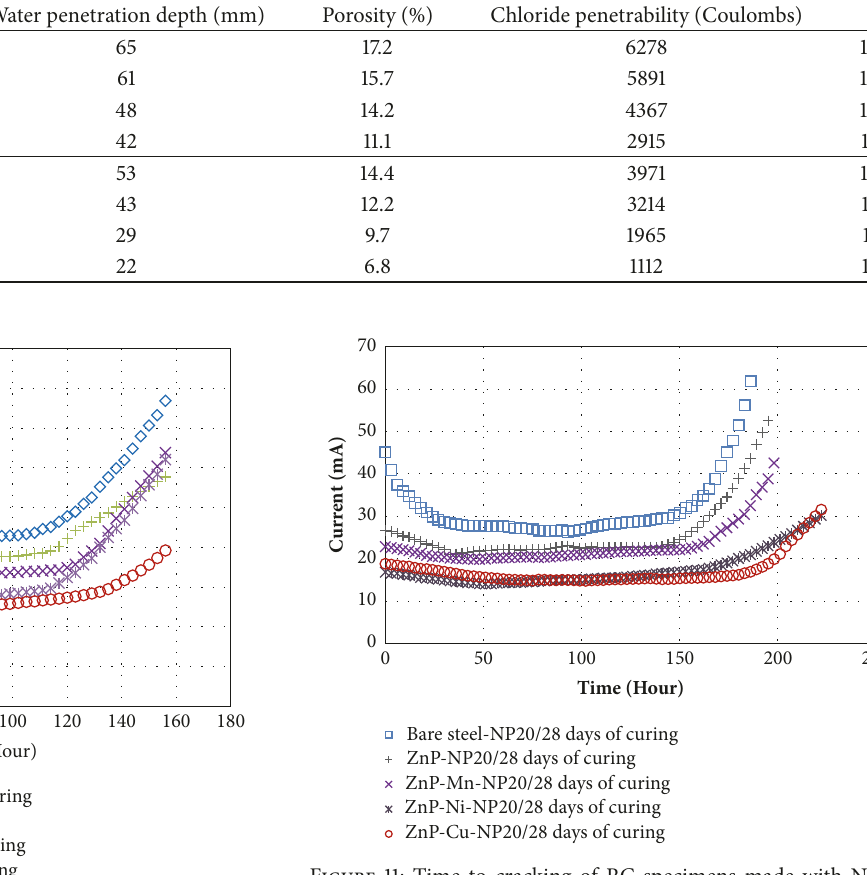
Figure 11: Time to cracking of RC specimens made with NP20- based cement and phosphated steel rebars after 28 days of curing. Figure 13 that the corrosion resistance of NP-based cement concrete specimens increased significantly with age while that of the plain cement concrete had a slight increase which has also been indicated by other researchers [36, 50].